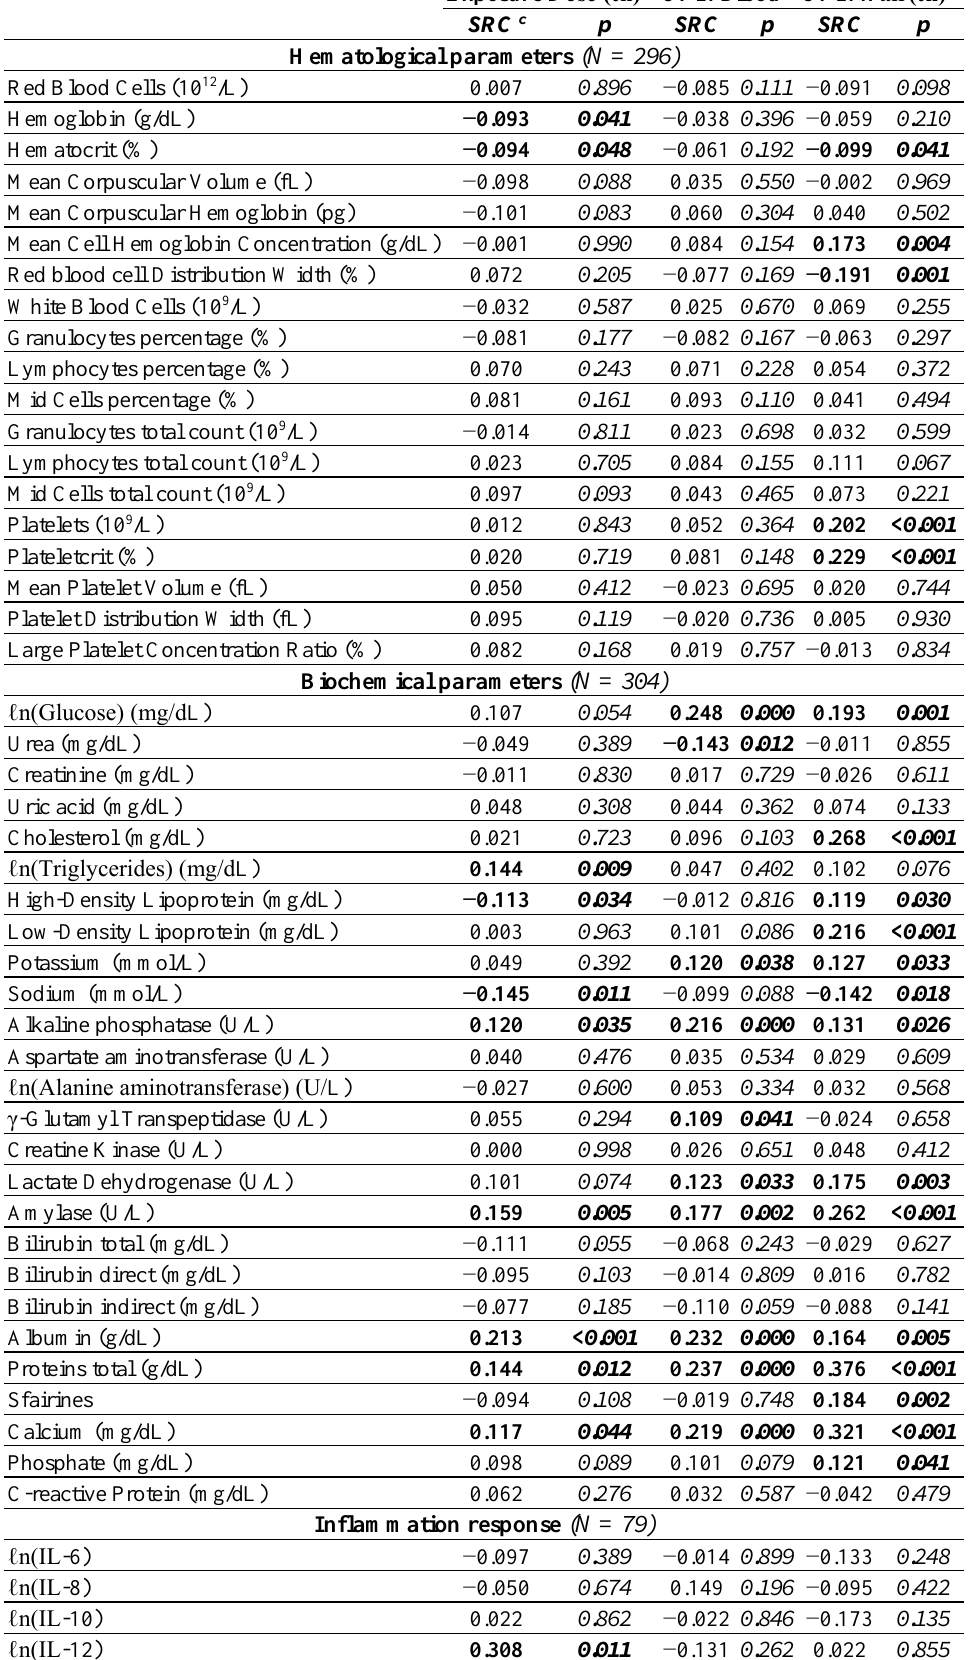
Table 4. Association of exposure dose, chromium in blood, chromium in hair with hematological/biochemical and other